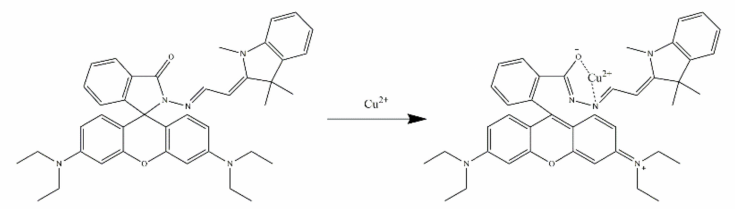
Zhang J., et al. constructed a FRET-based sensor for the detection of Cu 2+ (Table 1, No. 17) [24], by conjugating rhodamine with a 2-(1,3,3-trimethylindolin-2-ylidene) acetalde- hyde moiety. The designed sensor demonstrated colorimetric and ratiometric responses to Cu 2+ with a detection limit of 1.168 × 10 − 8 M (Figure 13). The prepared sensor was successfully applied to detect Cu 2+ by test paper strips and in real water samples.